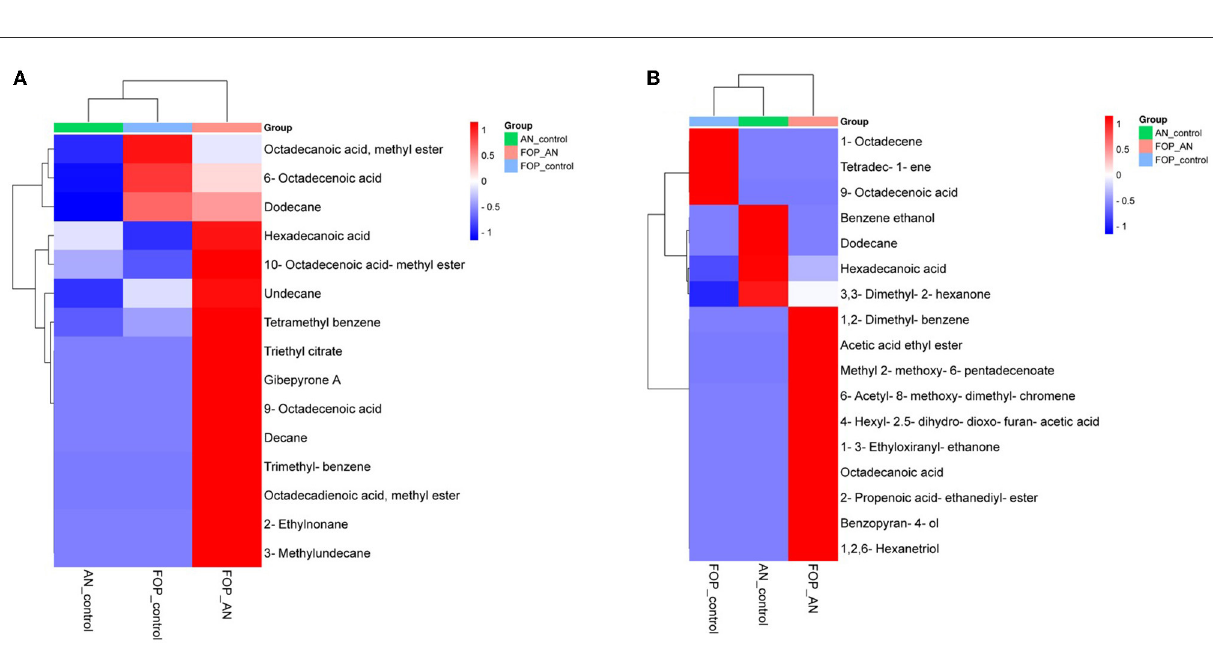
the highest mycelial inhibition of 74% was recorded, followed by Trichoderma spp., Bacillus spp. and, Pencillium spp. An in planta study carried out using guava pants (Allahabad Safeda) suggests that the application of A. niger to the soil near the root zone before the development of the disease will reduce the wilt incidence significantly, whereas, the control showed 100% wilt incidence with prominent symptoms. The wilted plants